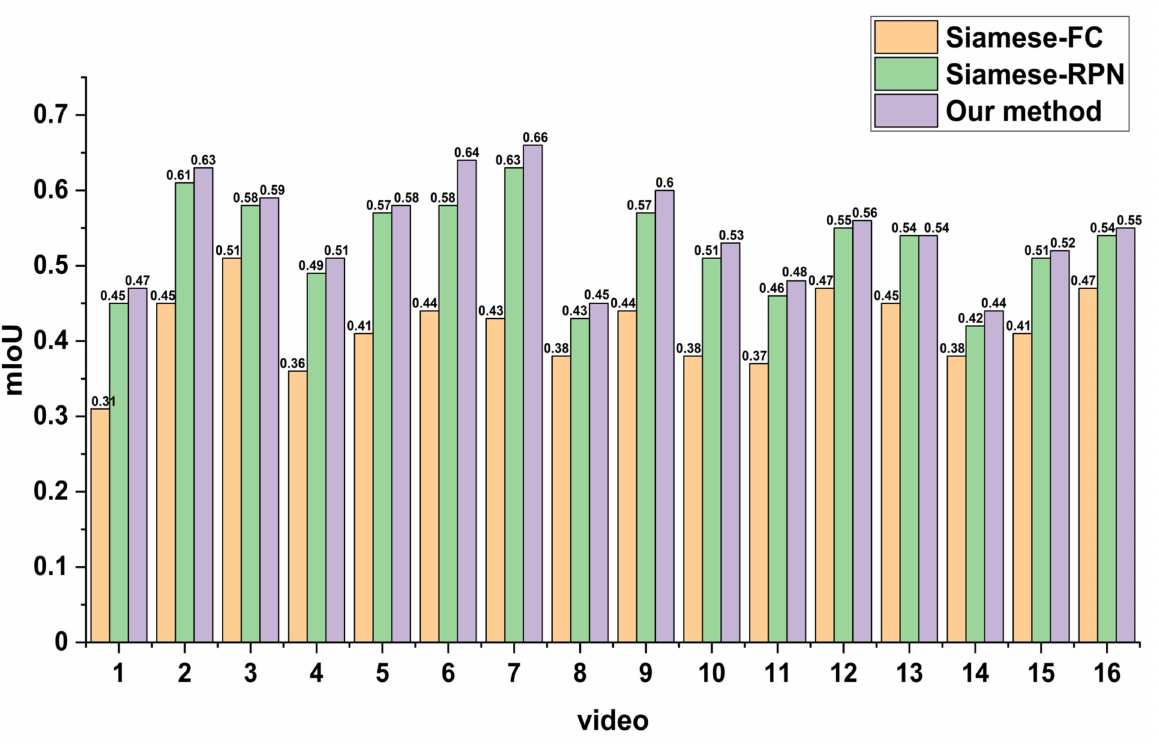
Figure 19. Accuracy comparison of the three